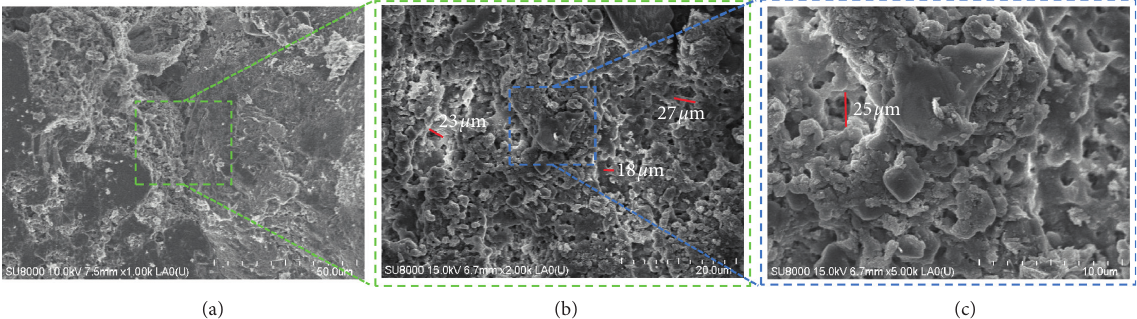
Figure 2: SEM images at various magnifications. (a) SEM image at 1000x. (b) SEM image at 2000x. (c) SEM image at 5000x.